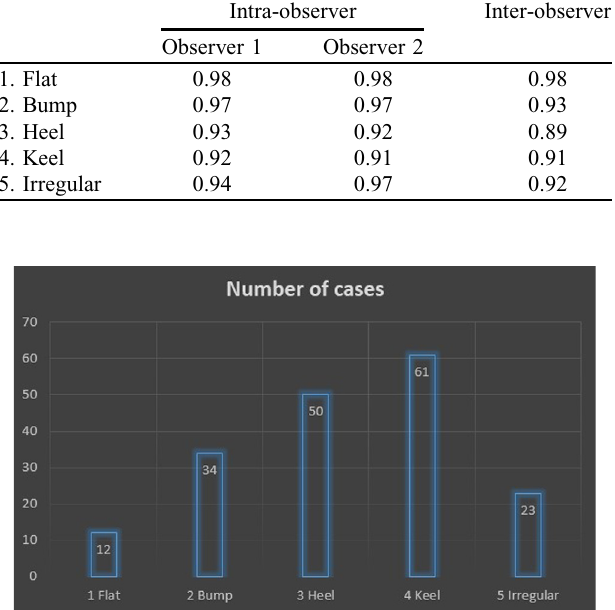
Figure 2. Distribution of the acromion spur type classified from the arthroscopic picture.